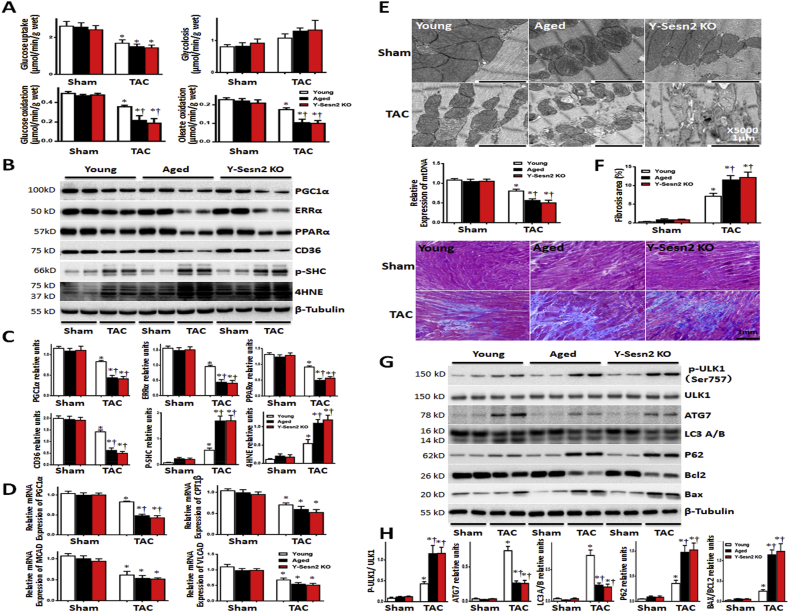
Regulation of substrate metabolism and autophagy in response to pressure overload. (A) Glucose uptake, glycolysis, glucose oxidation, and oleate oxidation in hearts from Y-Sesn2 KO, aged WT (Aged), and young WT (Young) mice at 4 weeks after TAC or sham surgery (n = 5–6 per group). (B) Immunoblot for indicated proteins from hearts of Y-Sesn2 KO, aged WT, and young WT mice at 4 weeks after TAC or sham surgery. (C) Quantification of relative expression levels of indicated proteins (n = 5–6 per group). (D) Relative mRNA expression analysis of PGC1α, carnitine palmitoyltransferase (CPT)1β, medium-chain acyl-CoA dehydrogenase (MCAD), and very-long-chain acyl-CoA dehydrogenase (VLCAD) in Y-Sesn2 KO, aged WT, and young WT mice at 4 weeks after TAC or sham surgery (n = 5–6 per group). (E) Representative transmission electron microscopy images of mitochondrial morphology in Y-Sesn2 KO, aged WT, and young WT hearts, as well as mitochondrial (mt) DNA levels from Y-Sesn2 KO, aged WT, and young WT mice at 4 weeks after TAC or sham surgery (n = 5–6 per group). (F) Masson Trichrome staining and expression analysis of Y-Sesn2 KO, aged WT, and young WT mice at 4 weeks after TAC or sham surgery (n = 5–6 per group). (G) Immunoblot for indicated proteins from hearts of Y-Sesn2 KO, aged WT, and young WT mice at 4 weeks after TAC or sham surgery. (H) Quantification of relative expression levels of indicated proteins (n = 5–6 per group). Values are mean ± SEM, *p < 0.05 vs. Sham group; †p < 0.05 vs. corresponding WT group.